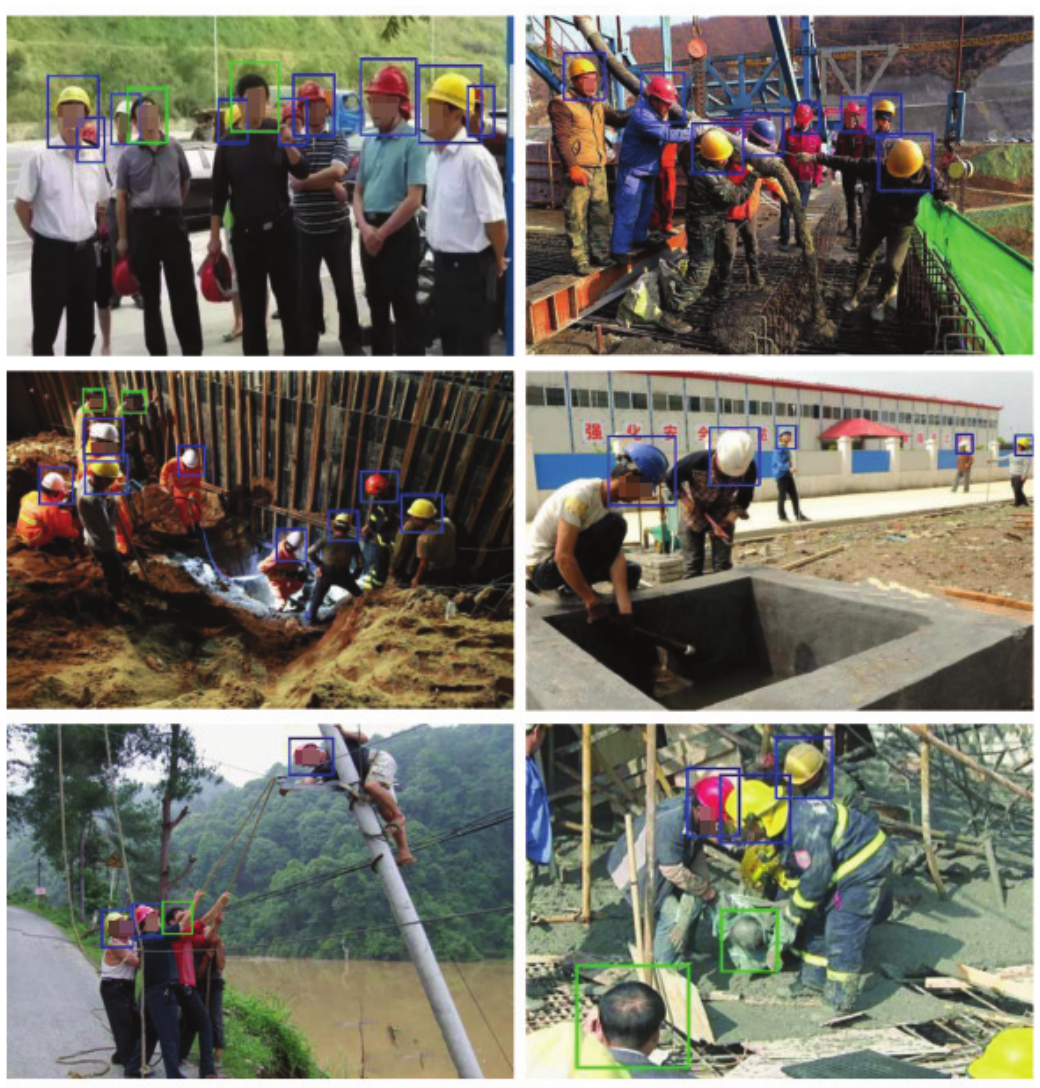
Figure 4. Examples of satisfactory detection results.